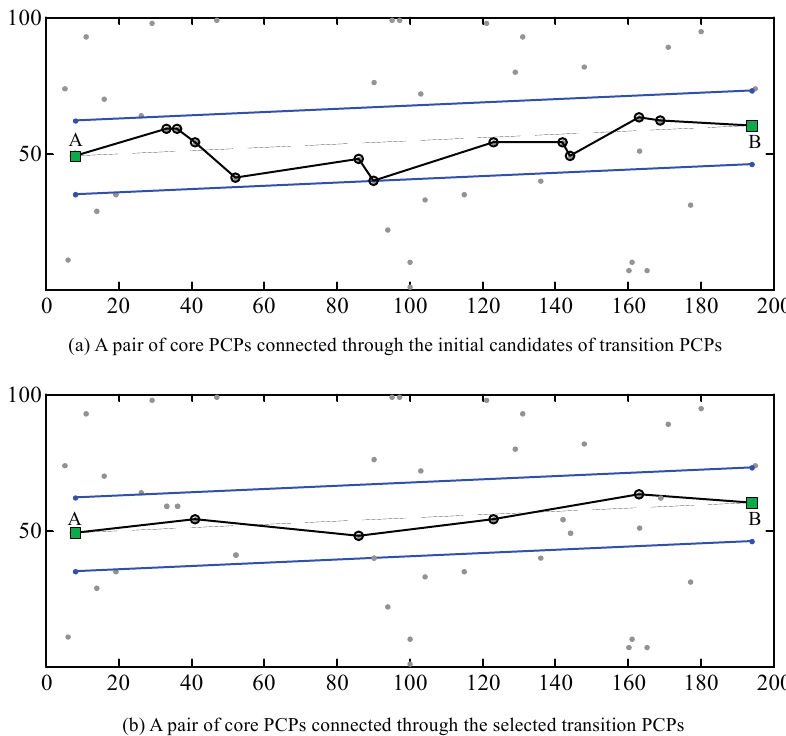
Figure 3. An example of the selection process of the transition primary control points (PCPs). The transition PCPs are selected from all the PSs located in the buffer defined by the blue lines around line AB, as shown in ( a ) to ( b ).